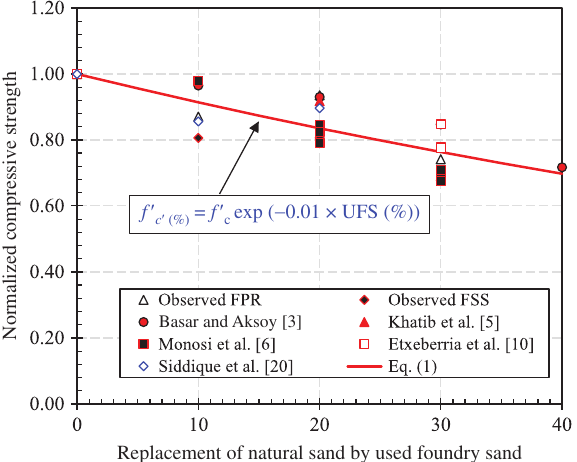
Figure 8: Comparison of observed values of compressive strength with the established database (Table